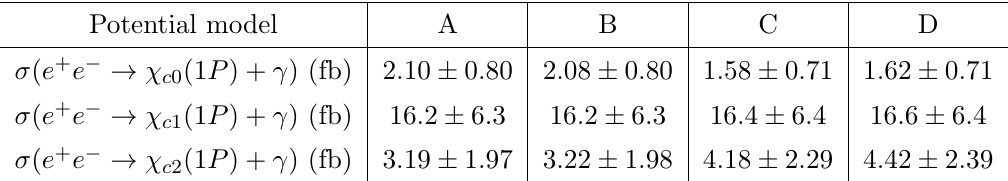
p s = 10 : 6 GeV for the potential